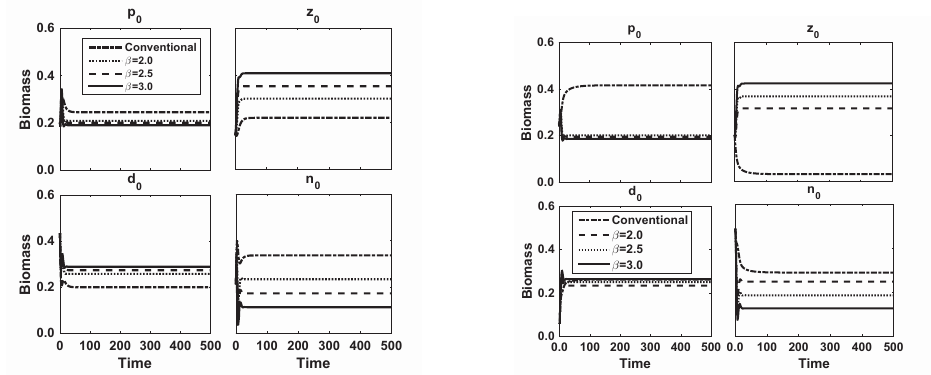
Figure 3. A significant increase in Z-biomass for N-dominating and D-dominating cases. Perturbations support higher trophic levels of NPZD